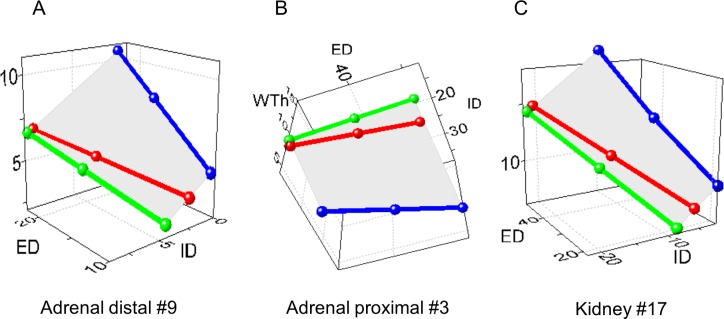
The distinct remodeling variants in hypertensive rats.(A) Adrenal distal segments of the external diameter (ED) ~10–20 μm were congruent with the variant #9, as other organs. (B) Adrenal proximal segments of ED ~30–50 μm were congruent with the variant #3. (C) The variant #17 appeared in the kidney. Axis X–external diameter ED; axis Y–internal diameter (ID); axis Z–wall thickness (WTh), μm.